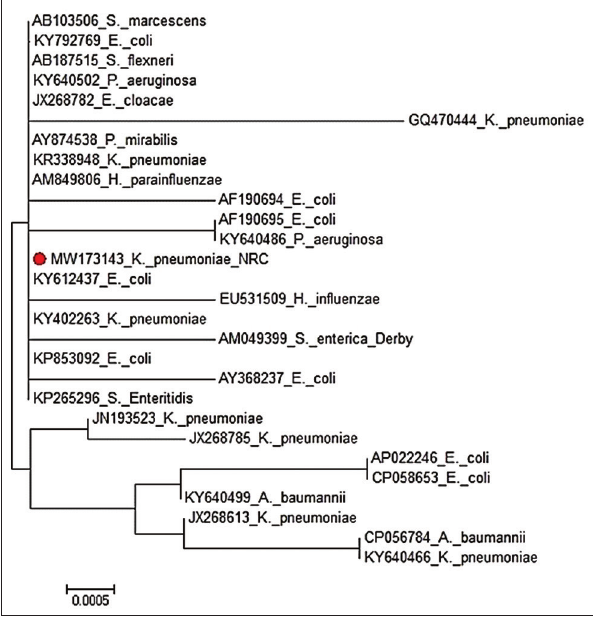
Figure-1: Phylogenetic relatedness of the bla maximum likelihood unrooted tree generated indicates the clustering of the test isolates with the other Gram-negative isolate bla TEM